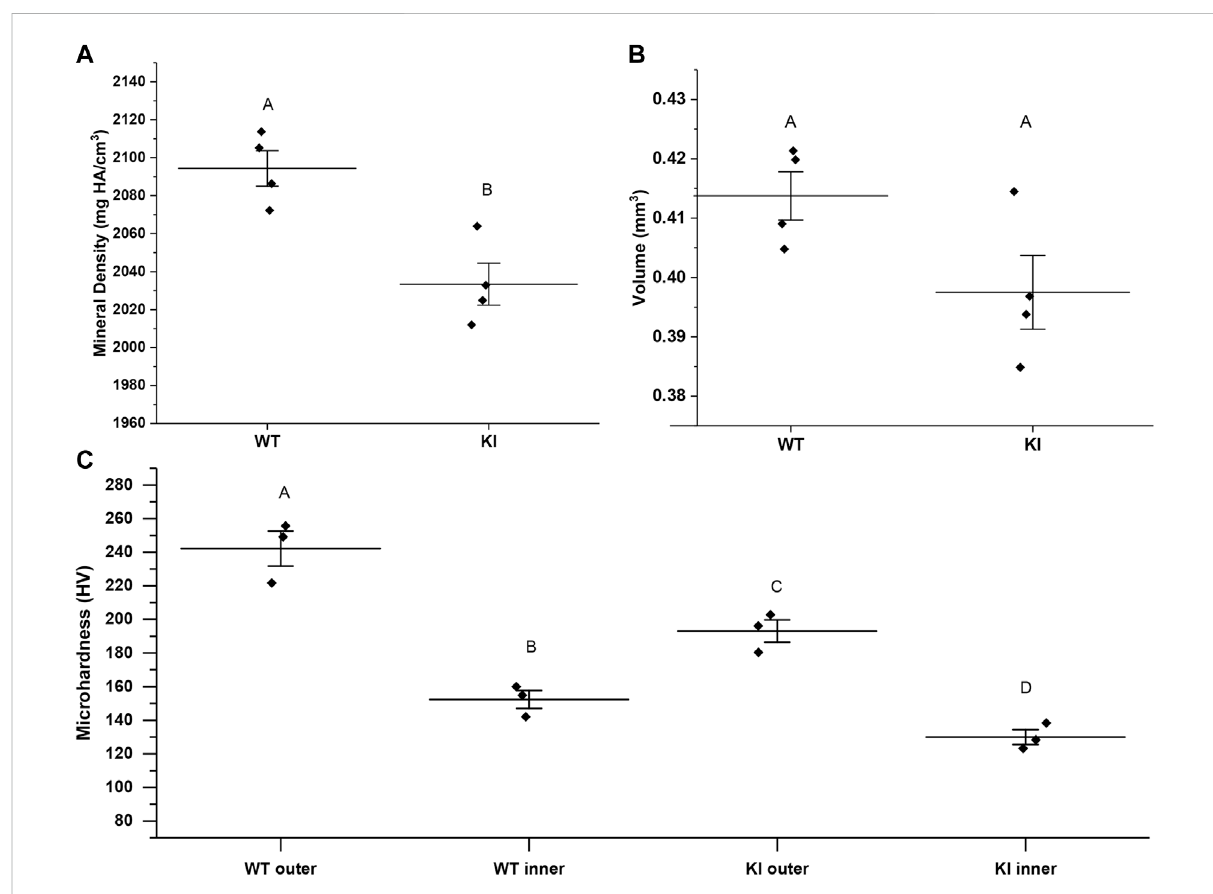
FIGURE 1 MicroCT analysis of mineral density (A) and volume (B) of enamel from 1 month-old WI and KI mice. (C) Microhardness values for 1-month-old WTandKI1stmolarenamel.Diamondsrepresentvaluesofindividualspecimens.Horizontallinesindicatemeansandwhiskersshowstandarderrors. Similar letters indicate populations which are not signi fi cantly different from each other.